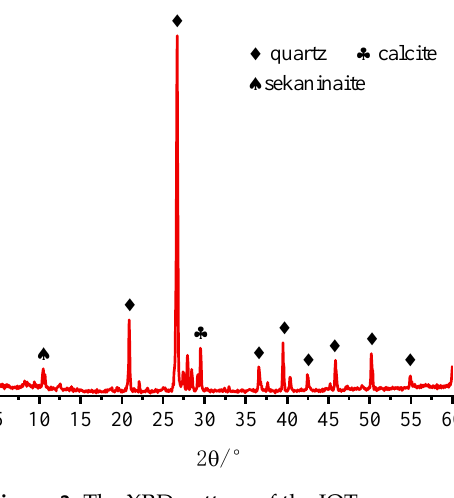
Figure 3. The XRD pattern of the IOT.